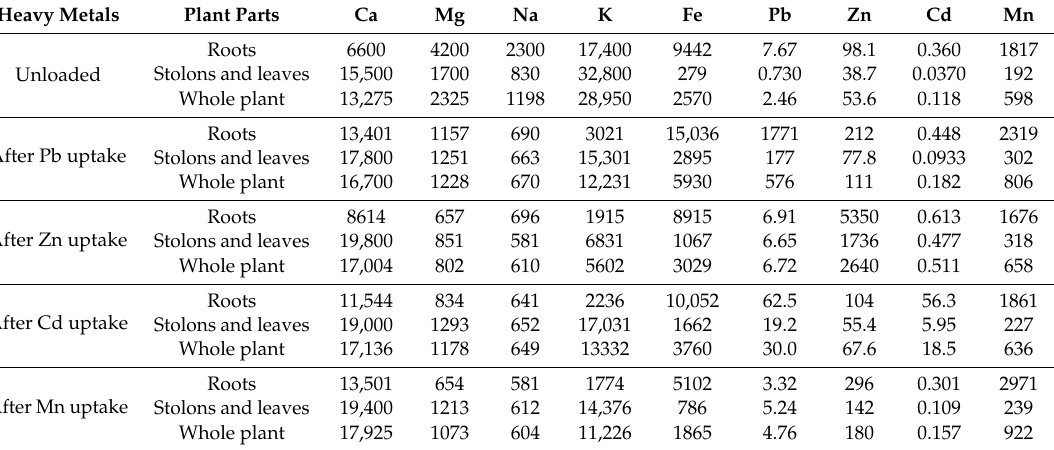
Table 7. Elemental contents in Eichhornia crassipes (mg /